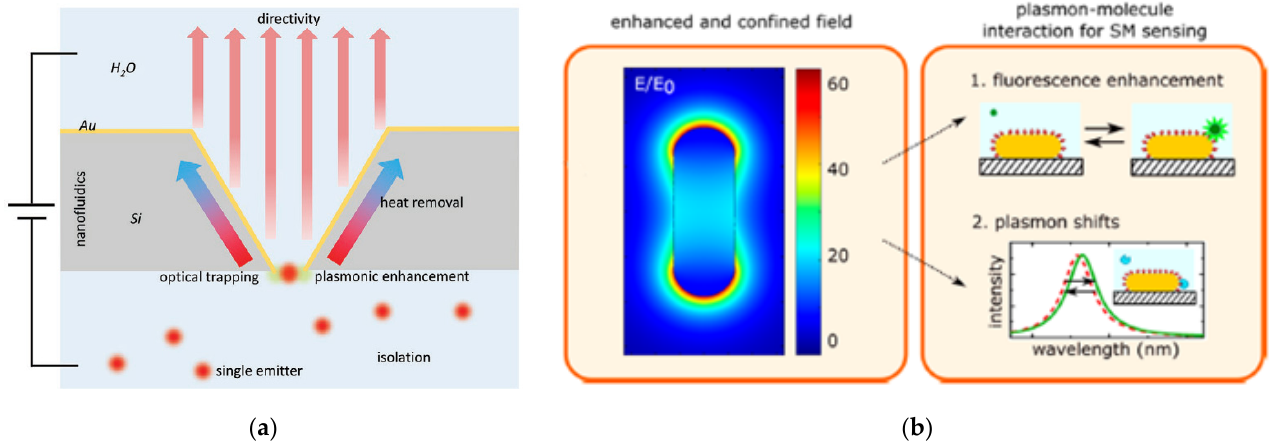
Figure 2. Schematic representation of plasmon-enhanced single-molecule sensing using nanoapertures and nanoparticles: ( a ) Nanoapertures (rectangle in an etched silicon film) in metal films (gold) for enhanced interaction with single emitters (shown as red glowing circles). The anisotropic etch produces a horn antenna for directive coupling. The aperture provides plasmonic enhancement for optical trapping. The aperture also serves as a nanopore for nanofluidic functionality, like monitoring ionic current from flow through the aperture Adapted with permission from Gordon et al. [27] Copyright © 2020 Wiley; ( b ) Nanoparticles: The plasmon resonance induces a strongly enhanced and tightly confined local field around the particles. The field shown here is for a gold nanorod that is excited on resonance. The local field mediates plasmon − molecule interactions, enabling enhanced single-molecule detection by monitoring plasmon-induced changes of the molecule (resulting in, e.g., fluorescence enhancement) or by monitoring molecule-induced changes of the plasmon (resulting in frequency-shifts of the plasmon). Adapted with permission from Taylor et al. [4] Copyright © 2017 American Chemical Society.